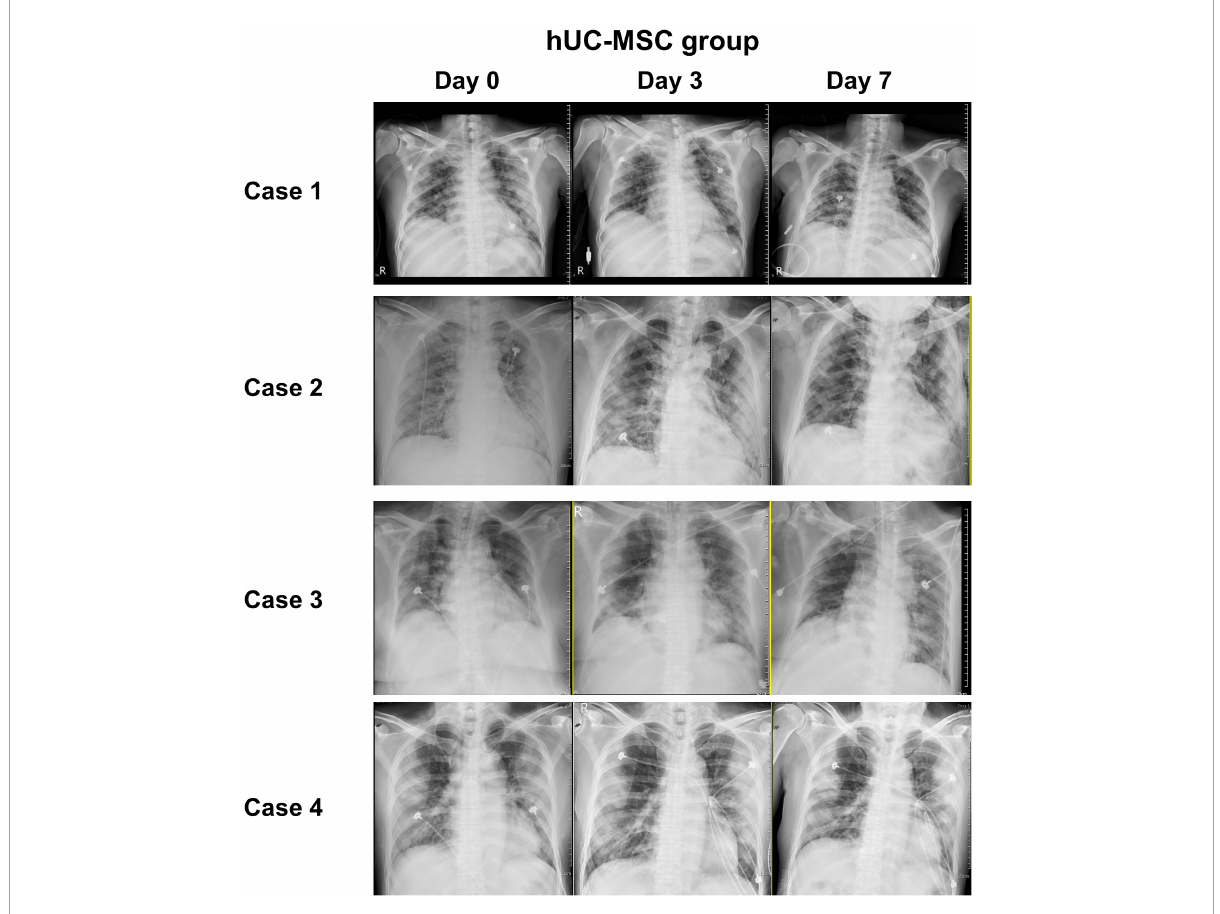
FIGURE5 Chest image records of hUC-MSC patients. Serial chest X-ray films obtained on admission day, post-hUC-MSC day 3, and post-hUC-MSC day 7 showed progressive improvements on pulmonary infiltrations in all patients receiving hUC-MSC infusions. Abbreviations as in Figure 2